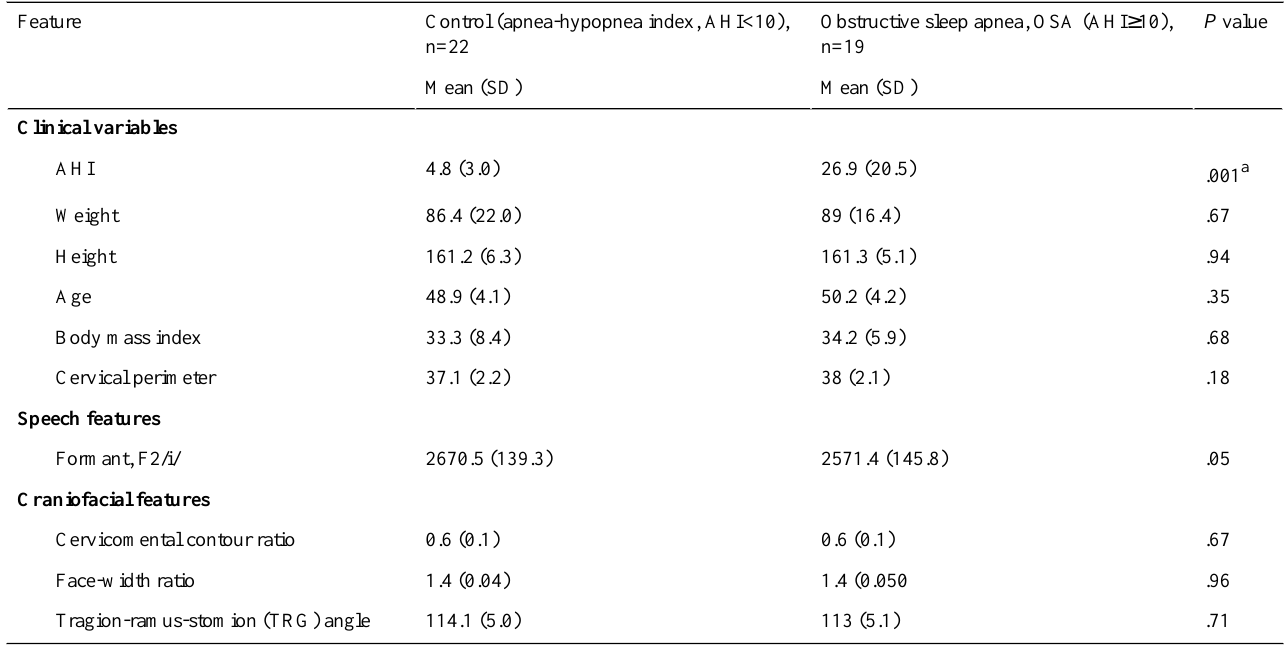
Table 11. Contrast between control and obstructive sleep apnea groups on a subset without differences either on age (41-55 years) or on body mass index ( ≥ 25) on the female population.